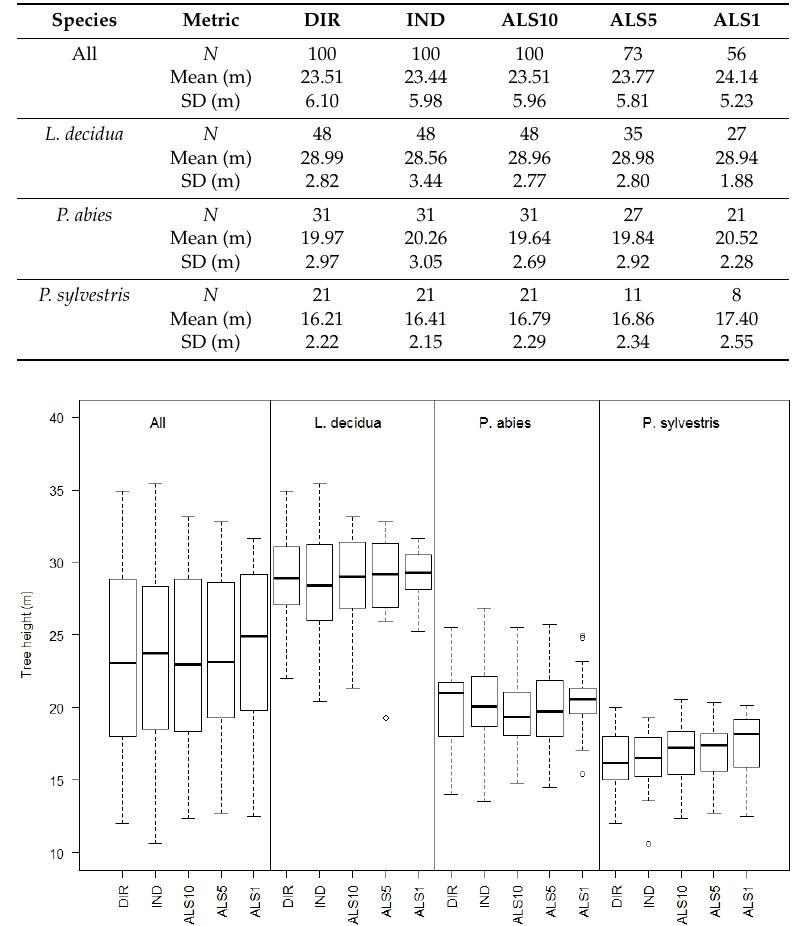
Figure 1. Box plots of tree heights distribution as measured by three survey methods (DIR = field direct measurement of felled trees; IND = traditional field ‐ based; ALS = Airborne Laser Scanning) of the whole dataset and considering the species. ALS data are presented divided by pulse densities (10, 5, 1 points/m 2 ) obtained through point cloud thinning.